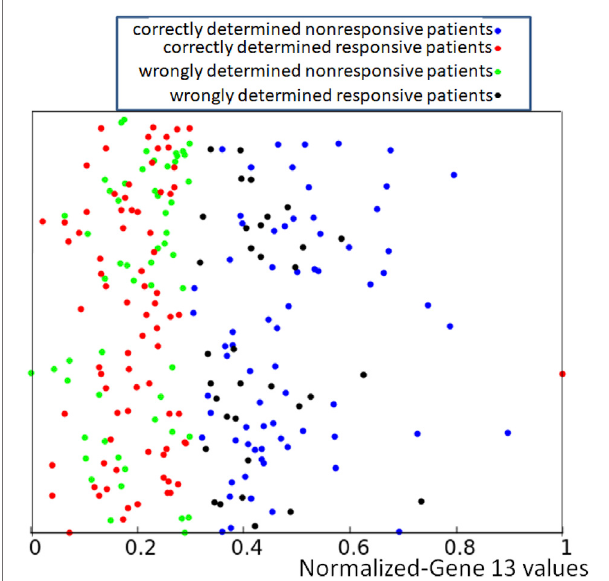
FIGURE 3 | The distribution of normalized values of correctly and wrongly determined therapies using the majority rule based on the histogram of Figure 1 . Red and blue points mark correctly determined responsive and nonresponsive records respectively. Black and green points mark wrongly determined responsive and nonresponsive records. The values of p 13, k are represented by the x-coordinate of marked points. The y-coordinate was randomly generated to differentiate points and it is the same as in Figure 2